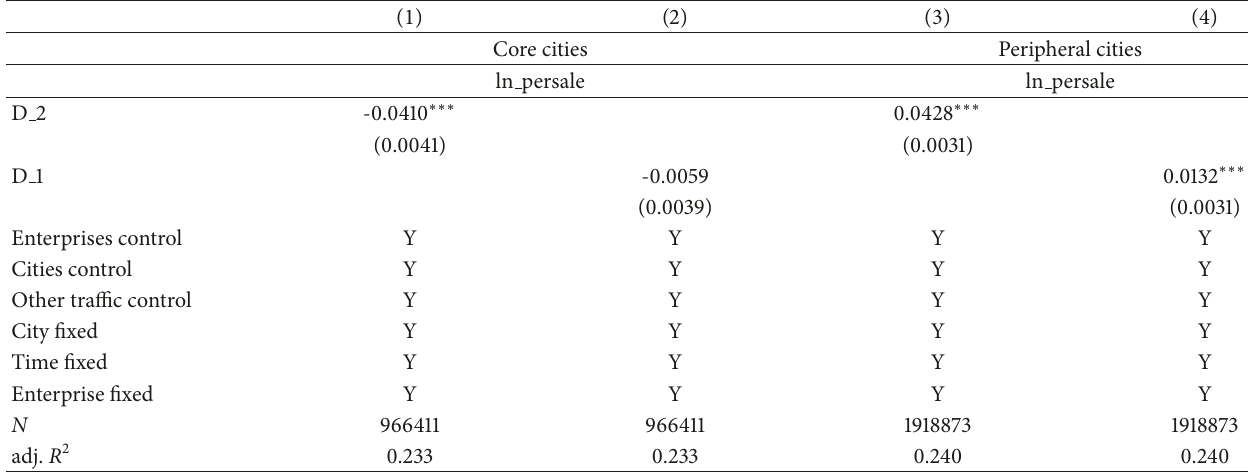
Table 13: Influence of HSR connection on enterprise productivity: placebo test.